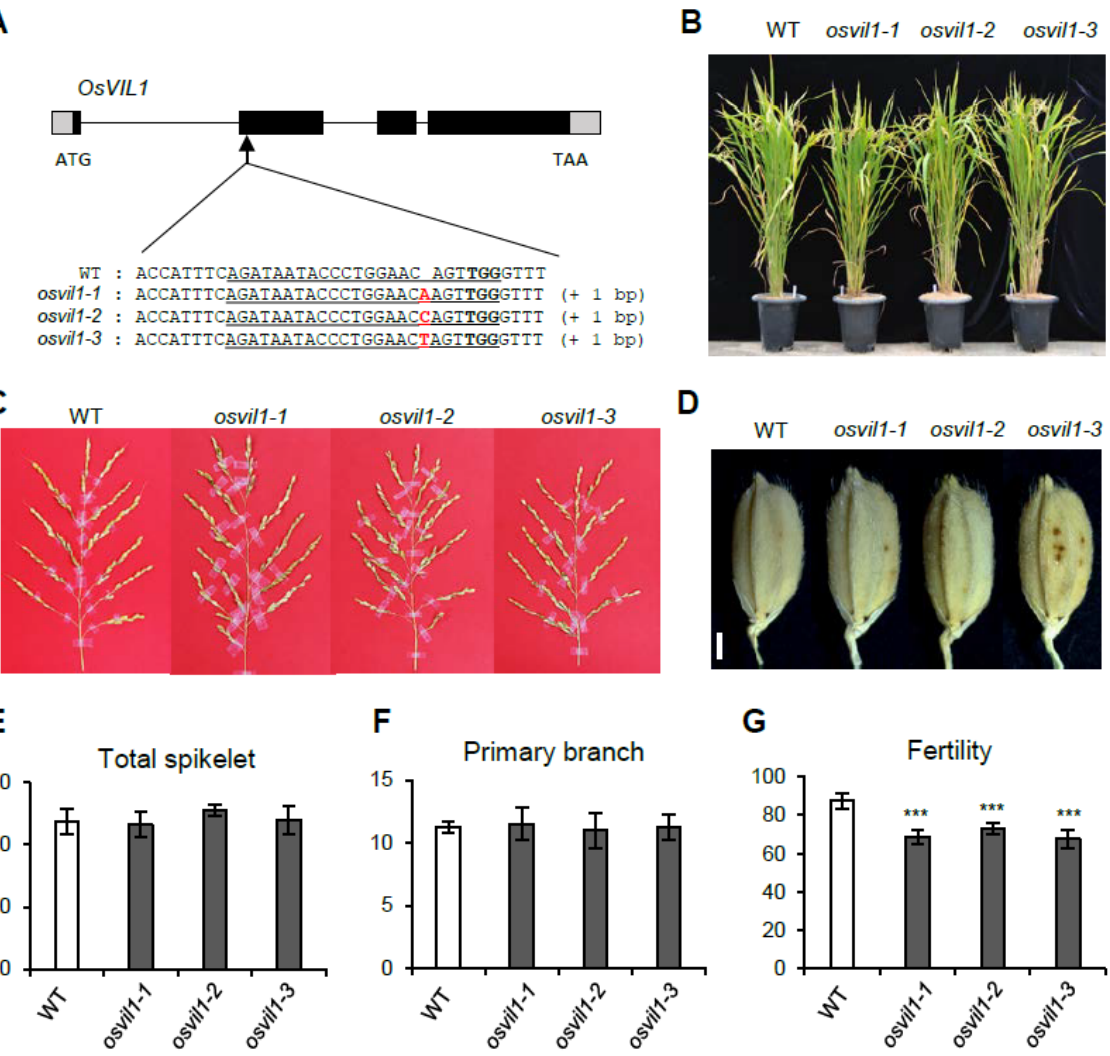
Figure 2. Phenotypes of the wild-type (WT) and osvil1 null mutants. ( A ) Schematic structure of OsVIL1 and mutation events obtained using the CRISPR/Cas9 method. In the gene structure, the black boxes indicate the four exons and the gray boxes indicate the 5 ′ UTR and 3 ′ UTR regions. The arrow indicates the mutation sites revealed using the CRISPR/Cas9 method. The target sequence is underlined with the protospacer adjacent motif shown in bold. Altered DNA sequences are indicated in red. ( B ) Phenotype of plant growth in WT and osvil1 mutants at the seed-ripening stage under paddy field conditions. ( C ) Panicle phenotypes. Bar = 2 cm. ( D ) Seed phenotypes. Bar = 1 mm. ( E ) Total number of spikelets on one panicle. ( F ) Number of primary branches on the main panicle. ( G ) Seed fertility. The error bars indicate the standard deviations, n = Statistical significance is indicated by *** ( p < 0.001).